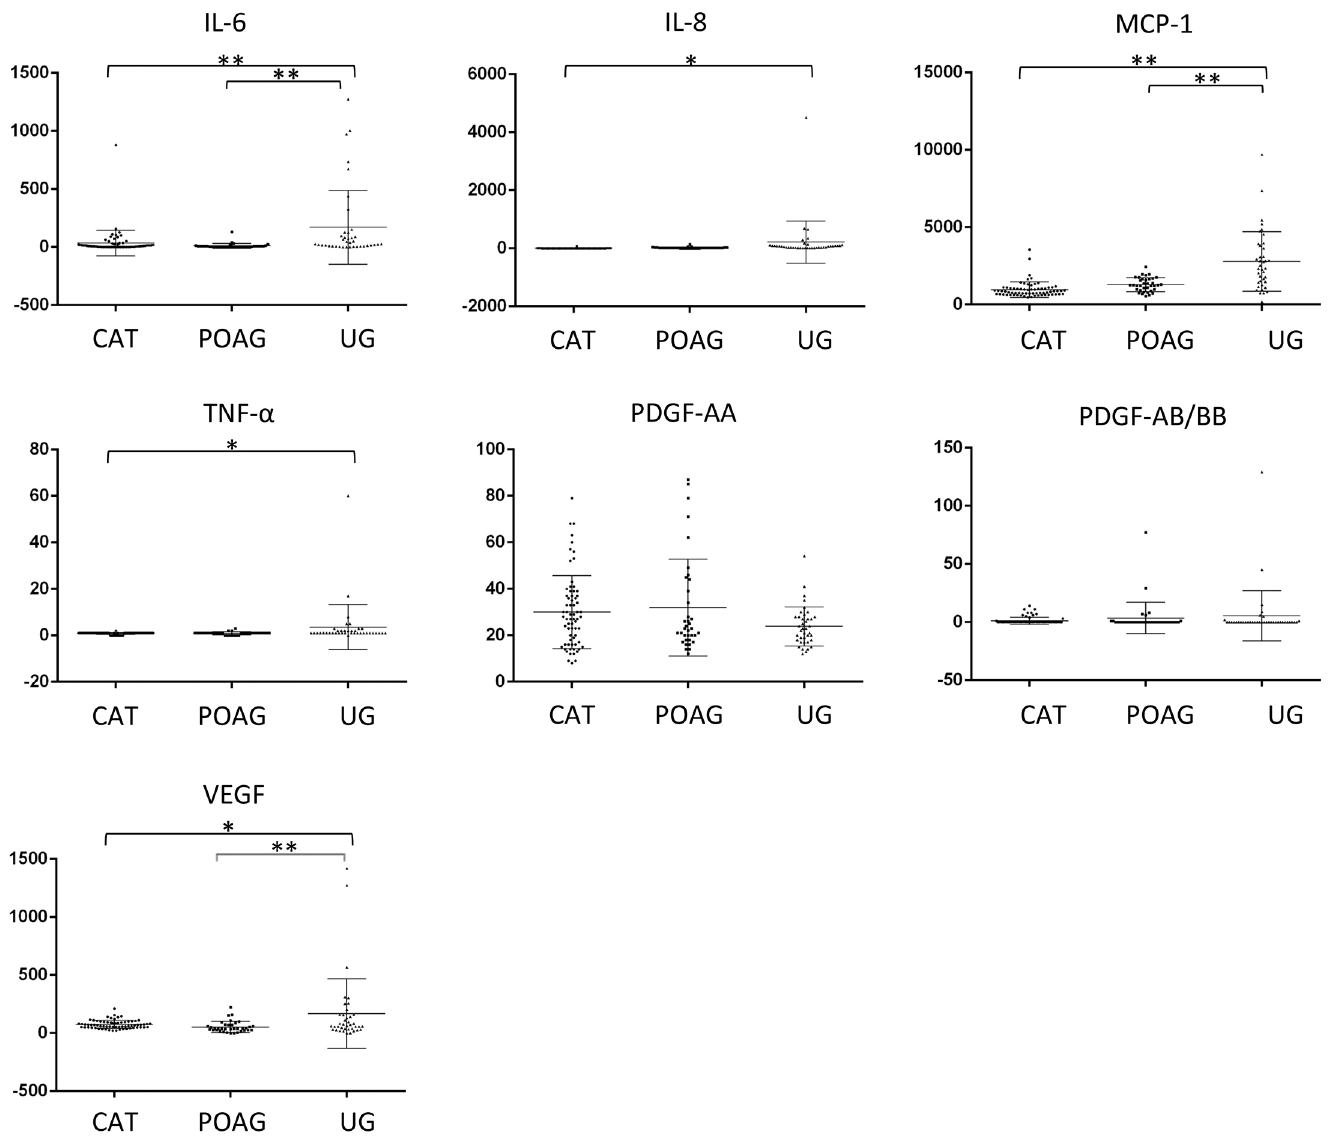
Fig 1. Comparison of levels (pg/mL) of analytes in the eyes of controls (cataractous, CAT) and in eyes with primary open-angle glaucoma (POAG), and uveitic glaucoma (UG). Data points ( n = 68 for CAT, n = 36 for OAG, and n = 39 for UG) represent individual samples. Error bars indicate medians ± interquartile range. * P < 0.05. ** P < 0.01. IL, interleukin, MCP, monocyte chemotactic protein, PDGF, platelet-derived growth factor, TNF, tumor necrosis factor, VEGF, vascular endothelial growth